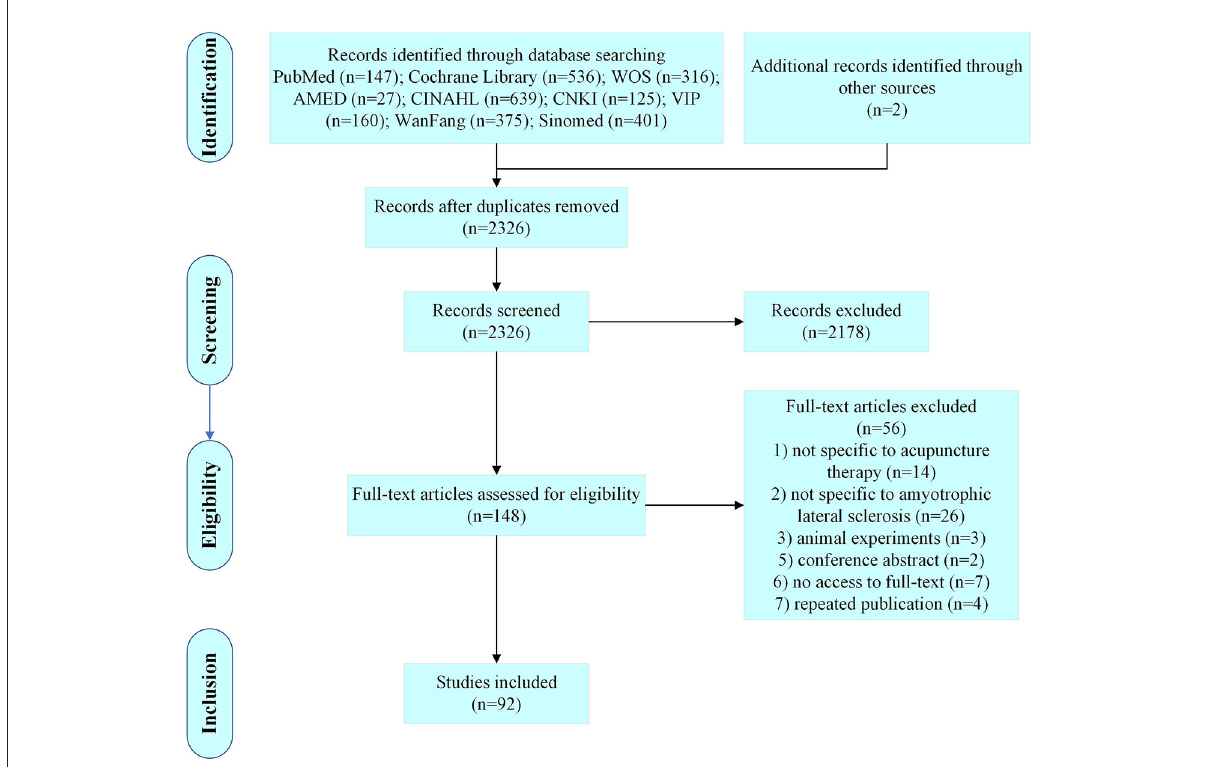
FIGURE1 Diagram for scoping review literature